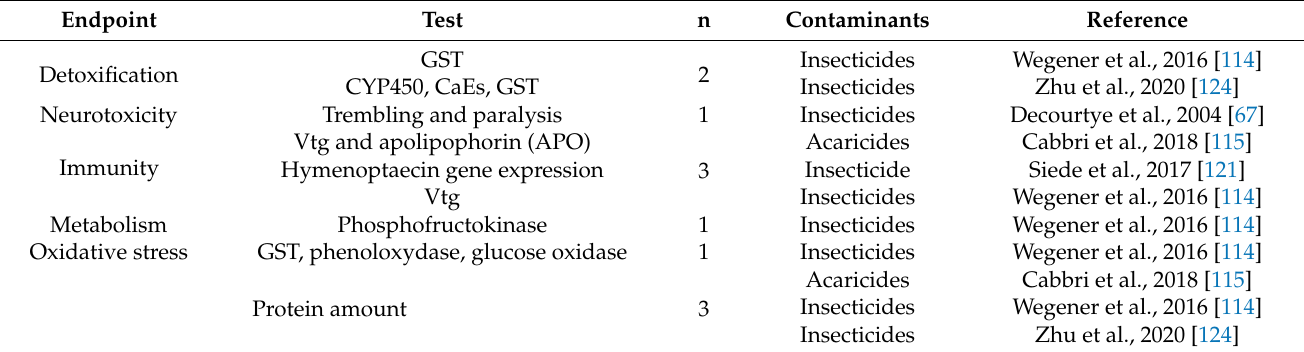
Table 4. Summary of semi-field studies divided by molecular and enzymatic endpoint and contaminants.